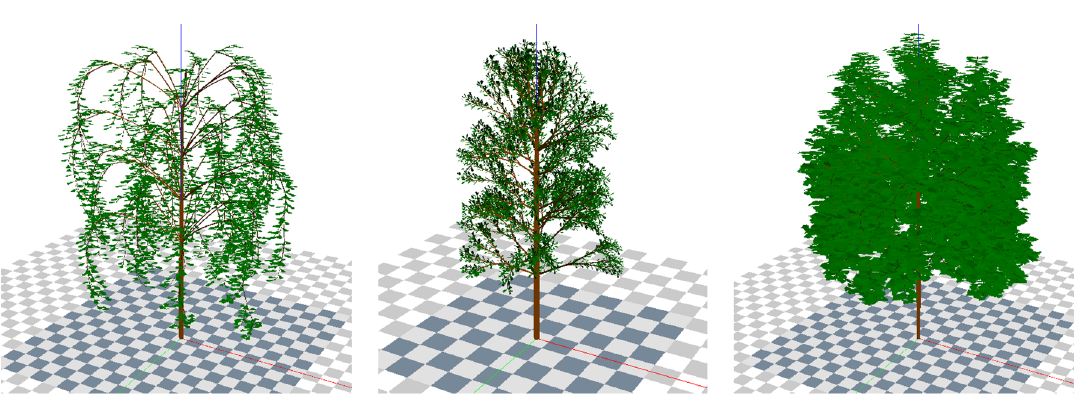
Figure 2. Example L-System for Silver Birch (Betula alba) ( left ), Mountain Ash (Sorbus araucaria) ( middle ), Field Maple (Acer campestre) ( right ).